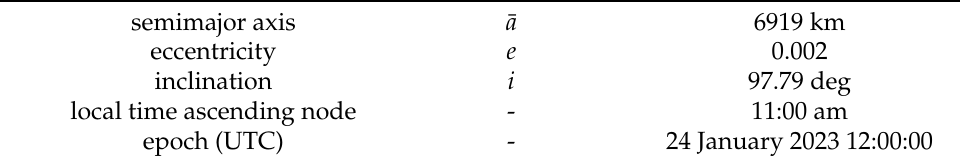
Table 1. SSO formation: orbit parameters chief satellite.